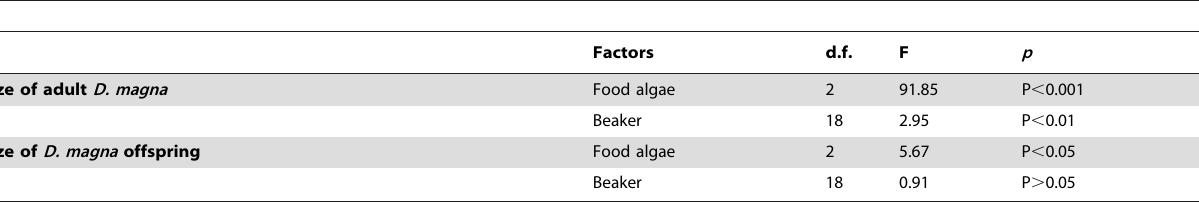
Table 2. Two-way nested ANOVA results for the effects of main groups (i.e. food algae Chlorella vulgaris , Stephanodiscus hantzschii, and Mixture) and subgroups (i.e. beakers) on adults and offspring of D. magna size.